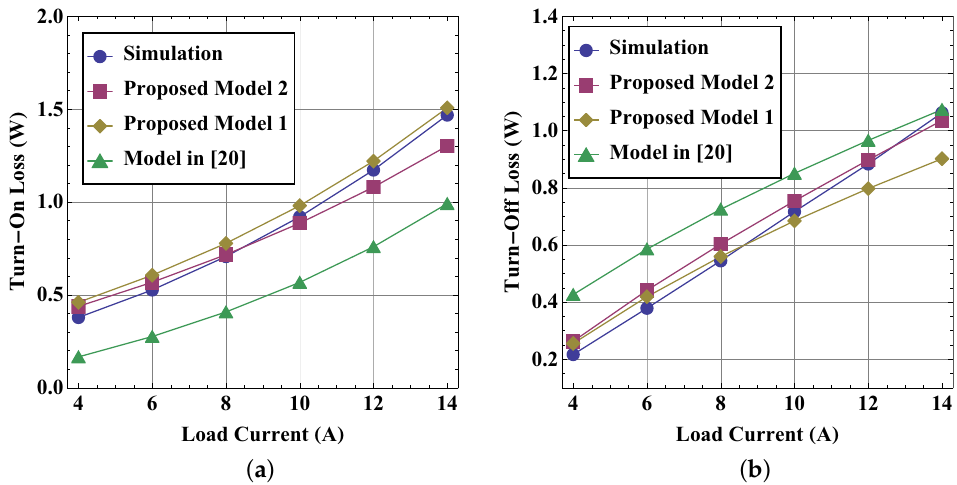
Figure 7. Switching loss of the models based on [20] at 10 MHz, 10 V input voltage, and 5 V gate driving voltage: ( a ) turn-on loss as a function of load current; ( b ) turn-off loss as a function of load current.